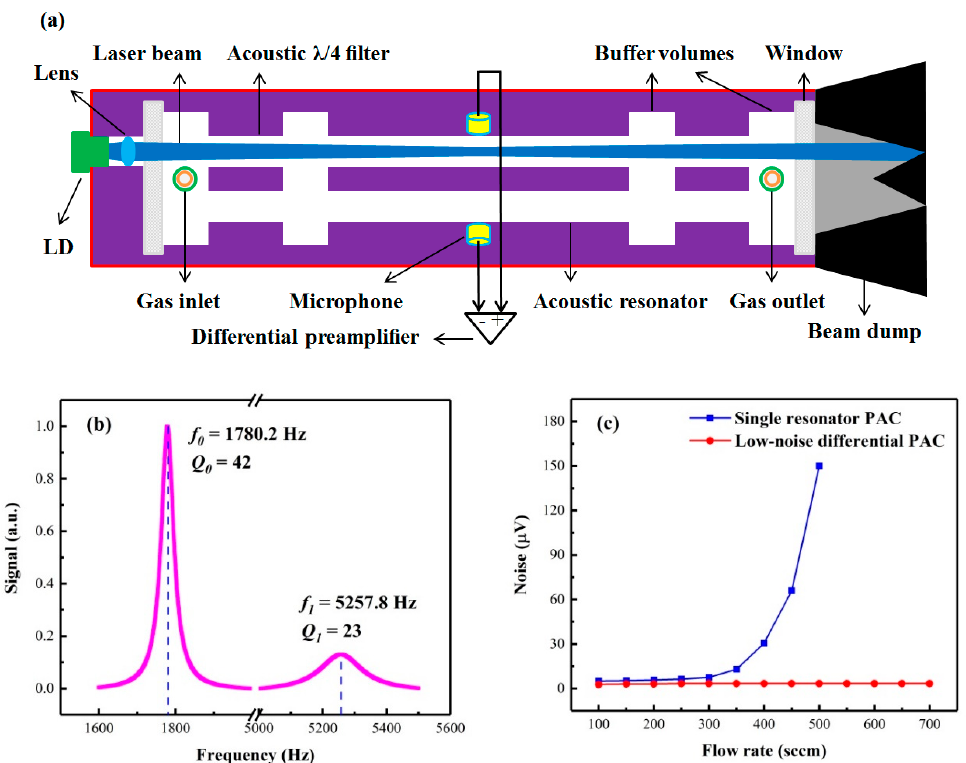
Figure 3. ( a ) Schematic of the photoacoustic detection module; ( b ) frequency response curves of the low-noise di ff erential photoacoustic cell (PAC) displaying the fundamental and first longitudinal vibrational modes; ( c ) dependence of PAC noise on gas flow rate as measured on di ff erent PAC